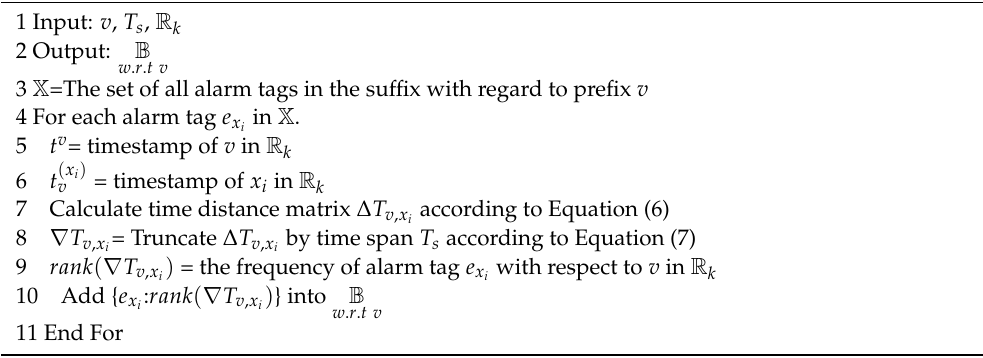
Algorithm 1 Major codes for building projection